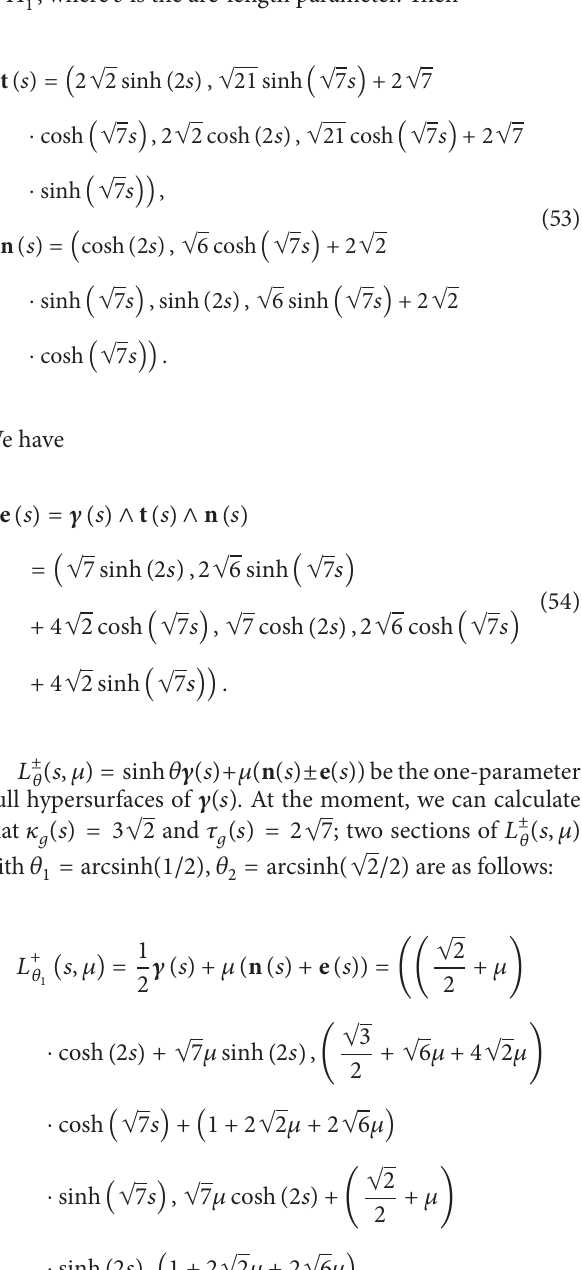
Figure 3: Projection of 𝐿 + 𝜃